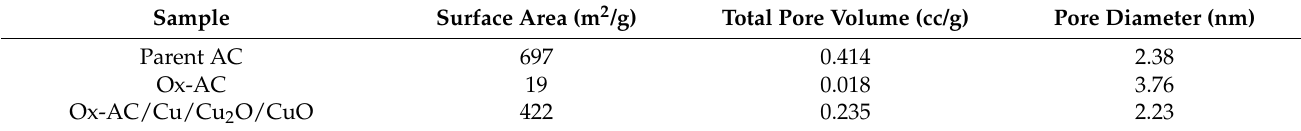
Figure 4. Pores distribution for parent AC, Ox-AC, and Ox-AC/Cu/Cu 2 O/CuO. Table 2. Surface area (BET), total pore volume, and pore size for parent AC, Ox-AC, and Ox-AC/Cu/Cu 2 O/CuO.